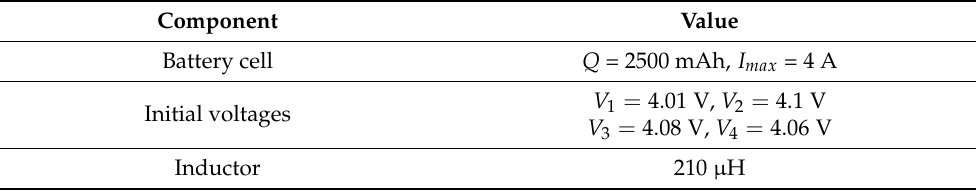
Table 4. Value of the components used in the simulation.